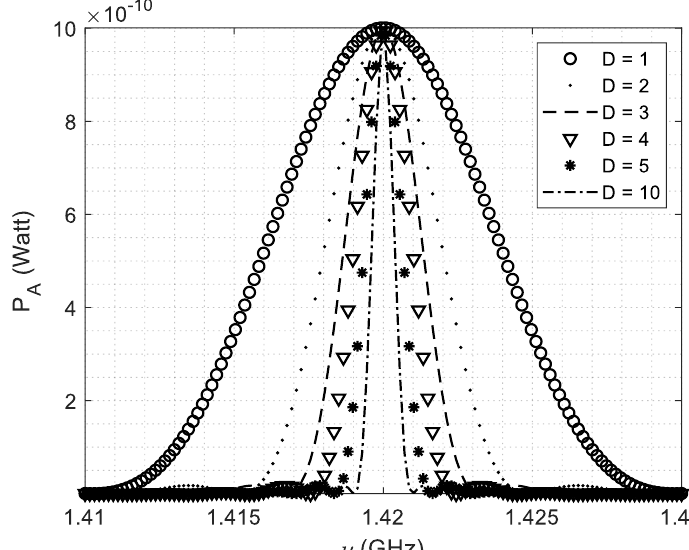
Figure 6: Antenna power (P ) due to observed the frequency (v) at different antenna A diameters (D = 1, 2, 3, 4, 5, and 10)